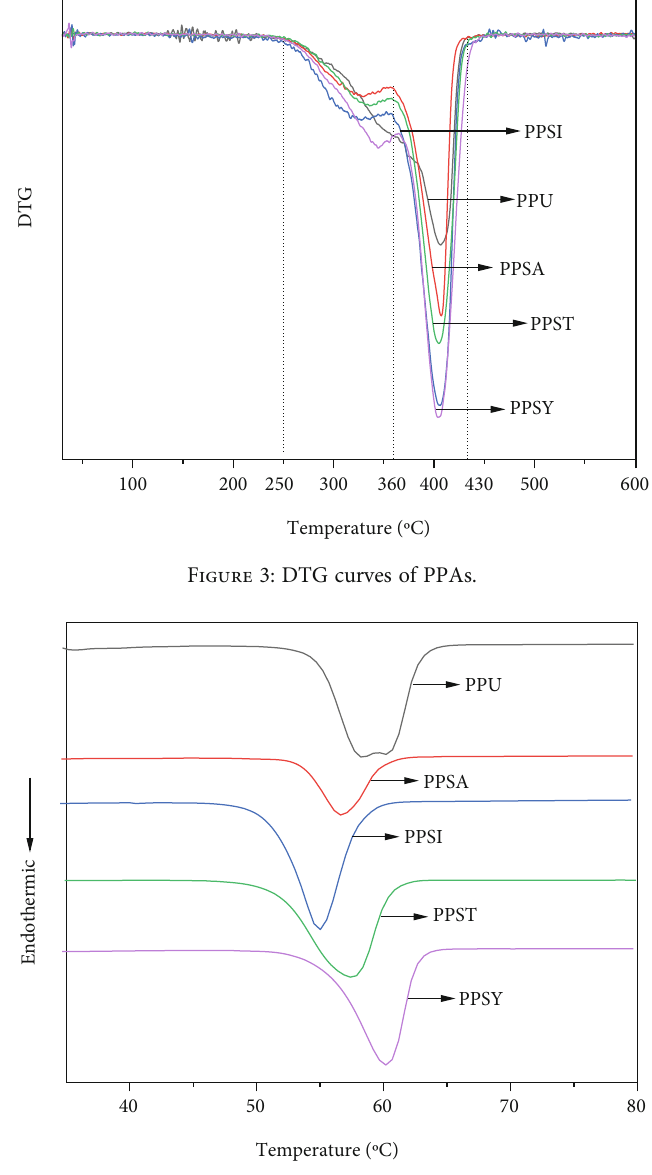
Figure 4: DSC curves of PPAs.